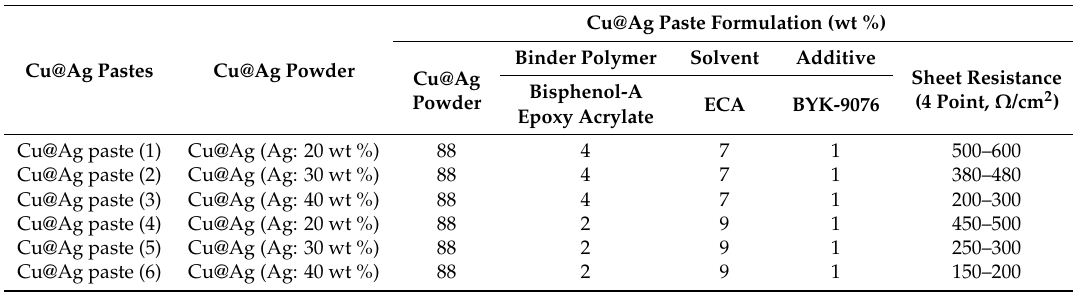
Table 3. Formulation of Cu@Ag nanoparticle pastes and properties.